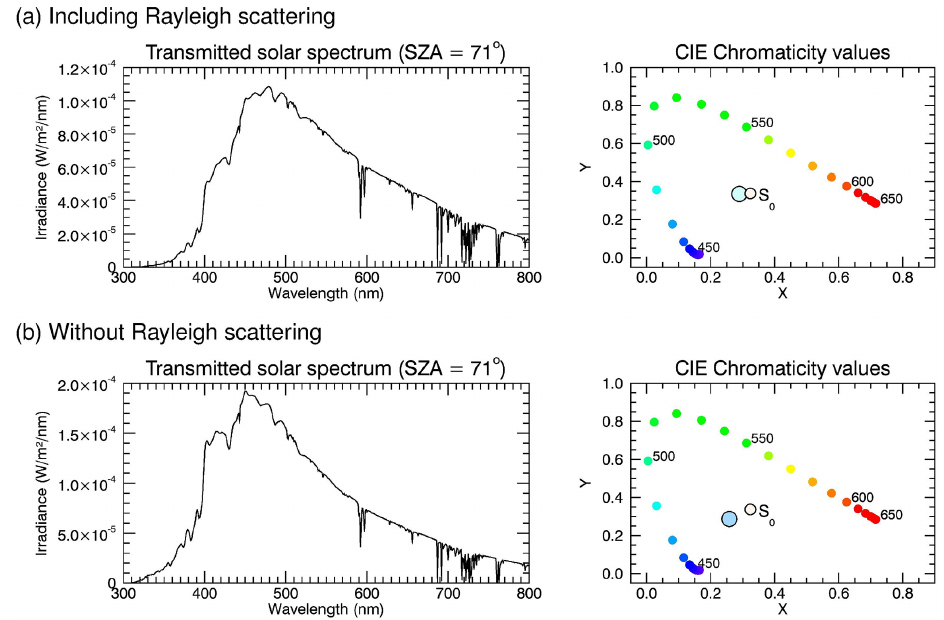
Figure 8. Similar to Fig. 4 but for the aerosol optical depth and aerosol extinction spectrum taken from Wilson (1951) including Rayleigh scattering (a) and without Rayleigh scattering (b)